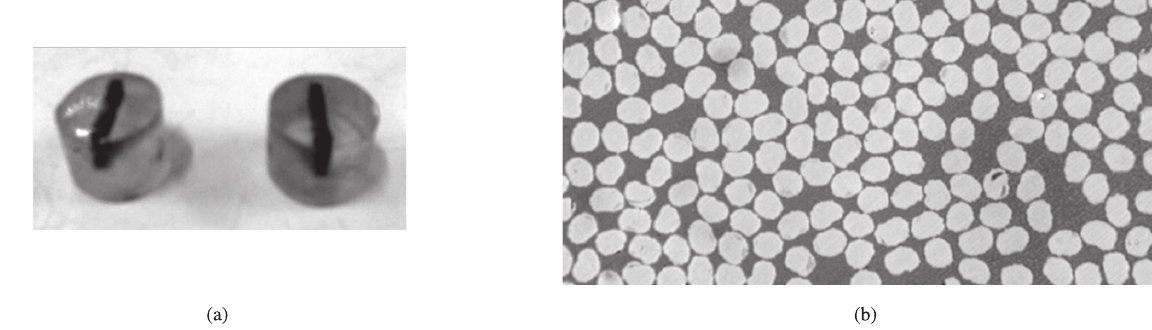
Figure 2. a) Composite in Epoxy (Stubs); and b) Optical micrograph showing cross sectional uniform distribution of carbon fibers in the epoxy